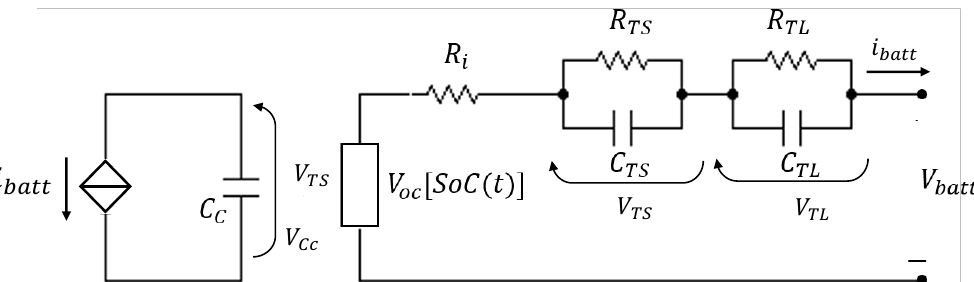
Figure 1. Equivalent circuit model: C c is the nominal capacity of the battery. The voltage across the capacitor, V C , corresponds to the SoC of the battery cell. V oc is the open circuit voltage and it c is a non linear function of the state of charge (SoC). The R i , R TS C TS and R TL C TL are responsible for instantaneous voltage drop, short-time and long-time constants,